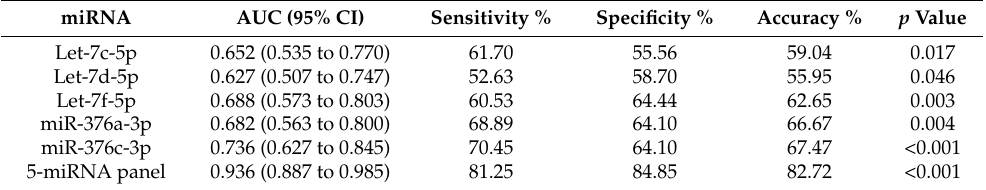
Figure 3. ROC curves for evaluating the predictive performance of differentially expressed miRNAs to discriminate between SI vs. NSI. ( A ) ROC curves for let-7c-5p, let-7d-5p, let-7f-5p, miR-376a-3p and miR-376c-3p. ( B ) The ROC curve of the 5-miRNA panel combination value of let-7c-5p, let-7d- 5p, let-7f-5p, miR-376a-3p and miR-376c-3p. AUC: area under the curve; miRNA: microRNA; NSI: non-statin intolerant; SI: statin intolerant. Table 3. Assessment of the potential diagnostic value of differentially expressed miRNAs and the 5-miRNA panel (let-7c-5p, let-7d-5p, let-7f-5p, miR-376a-3p and miR-376c-3p) as biomarkers to categorize statin intolerant patients. AUC: area under the curve; CI: confidence interval; miRNA: